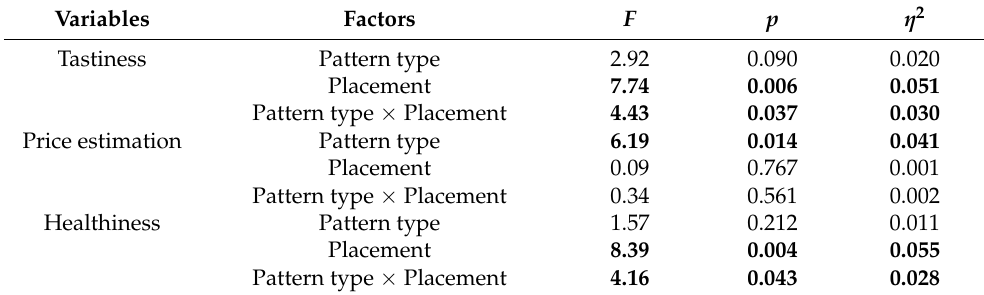
Table 5. ANOVA for compound judgment in Experiment 3 ( n = 149). For the different tests, DFn = 1 and DFd = 147. Bolded indicates statistically